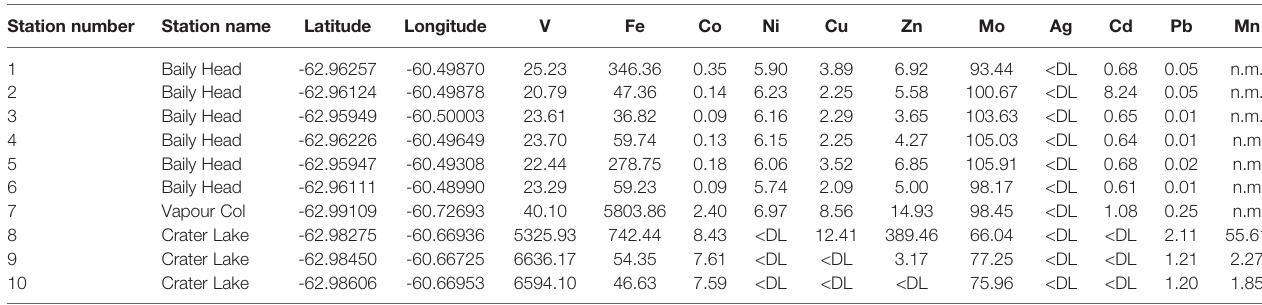
TABLE 2 | TM concentrations at all sampled stations (values in